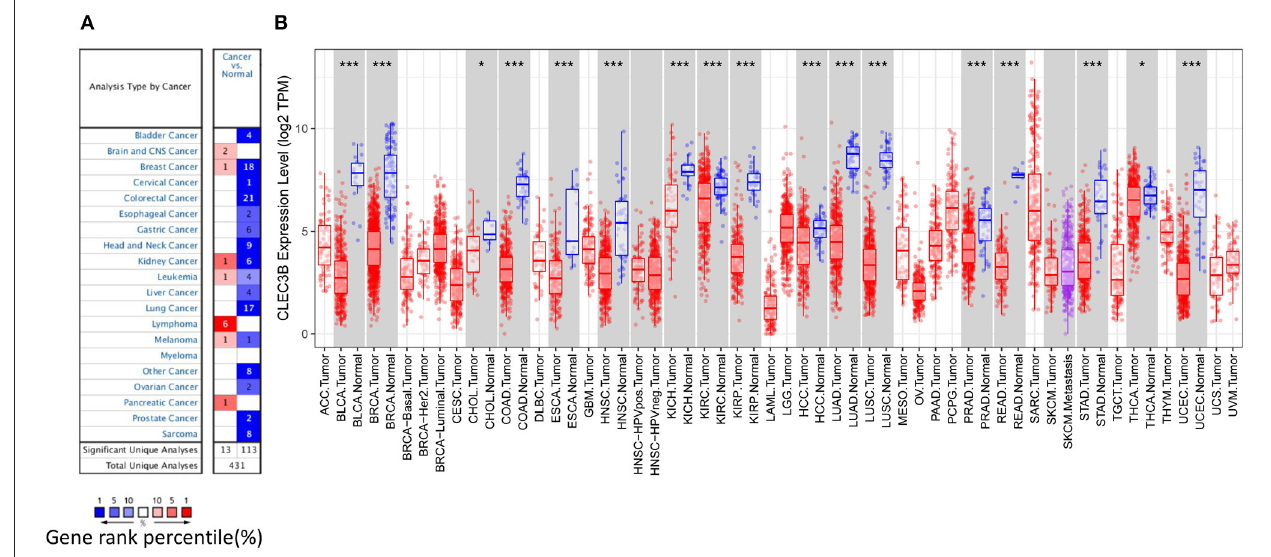
FIGURE 1 | CLEC3B expression levels in various types of cancer tissues or tumor cells. (A) Expression levels of CLEC3B in various normal or cancer tissues via Oncomine analysis. (B) Expression levels of CLEC3B in various normal or tumor cells via TIMER analysis (* P < 0.05, *** P <